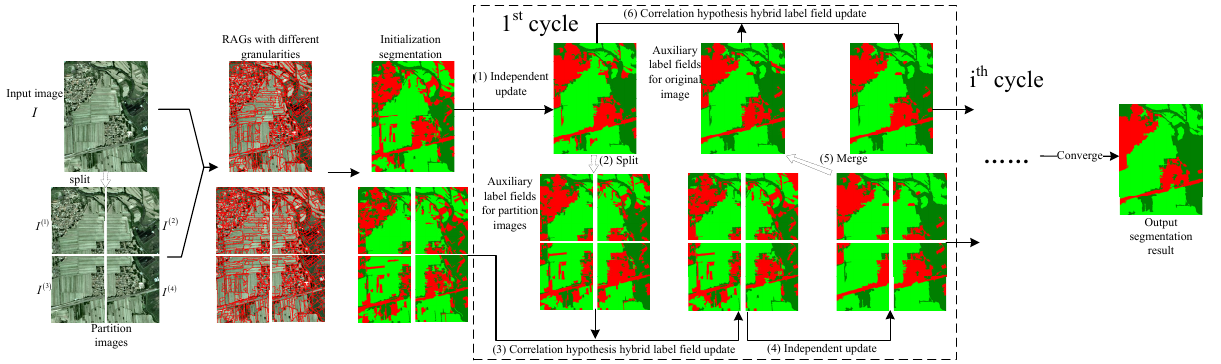
Figure 2. The flowchart of the proposed OMRF-PGAU.